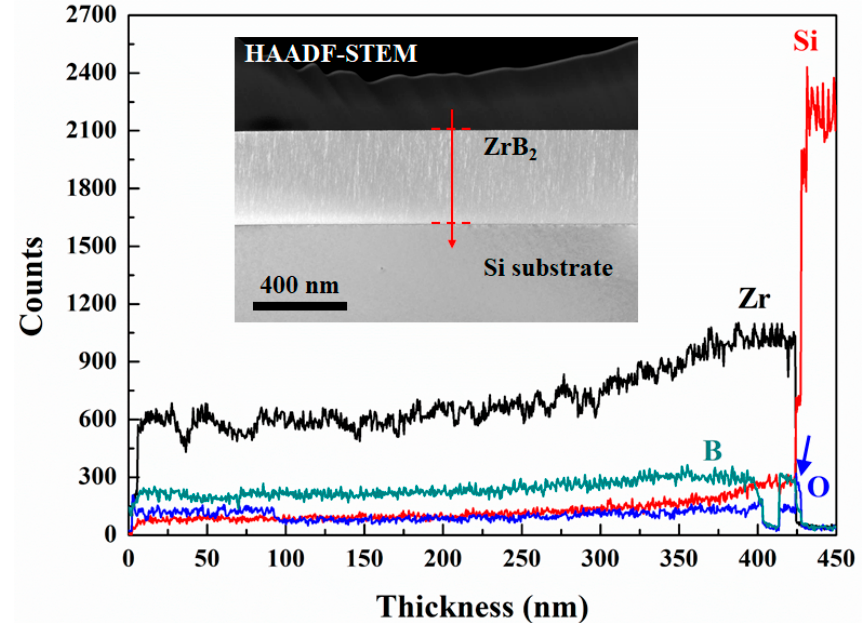
Figure 4. The TEM-EDS line scan measured along the depth of the ZrB 2 film. HAADF-STEM image shown in the inset of Figure 4. The inset shows that the ZrB 2 is uniformly distributed.